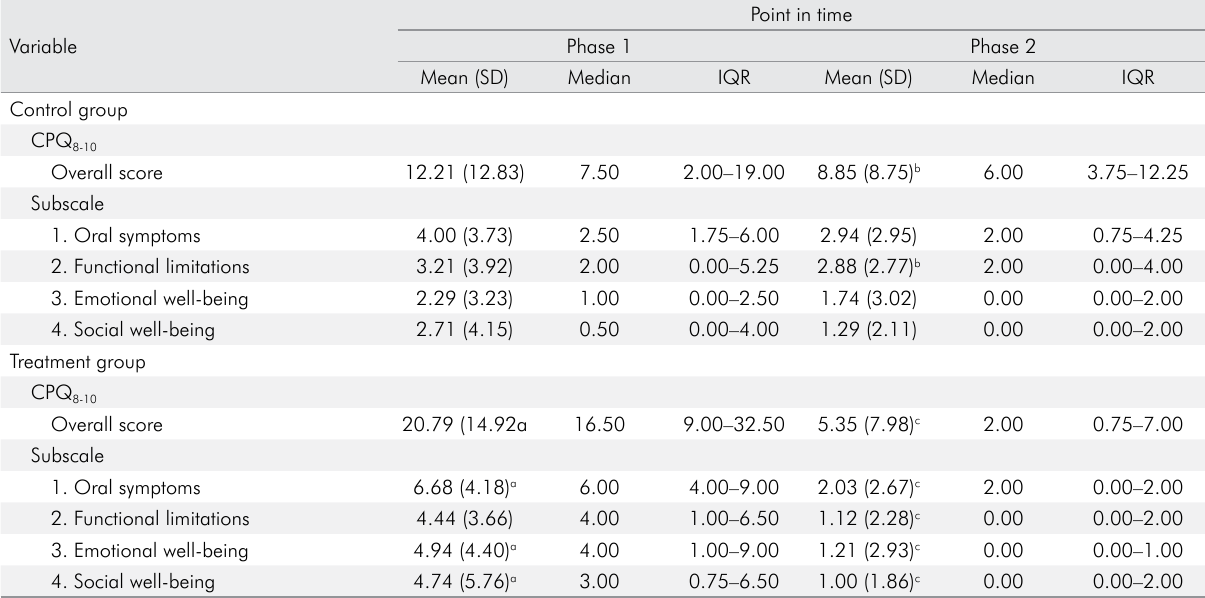
Table 4. Measures of central tendency and variability in CPQ and treatment groups in Phases 1 and 2].